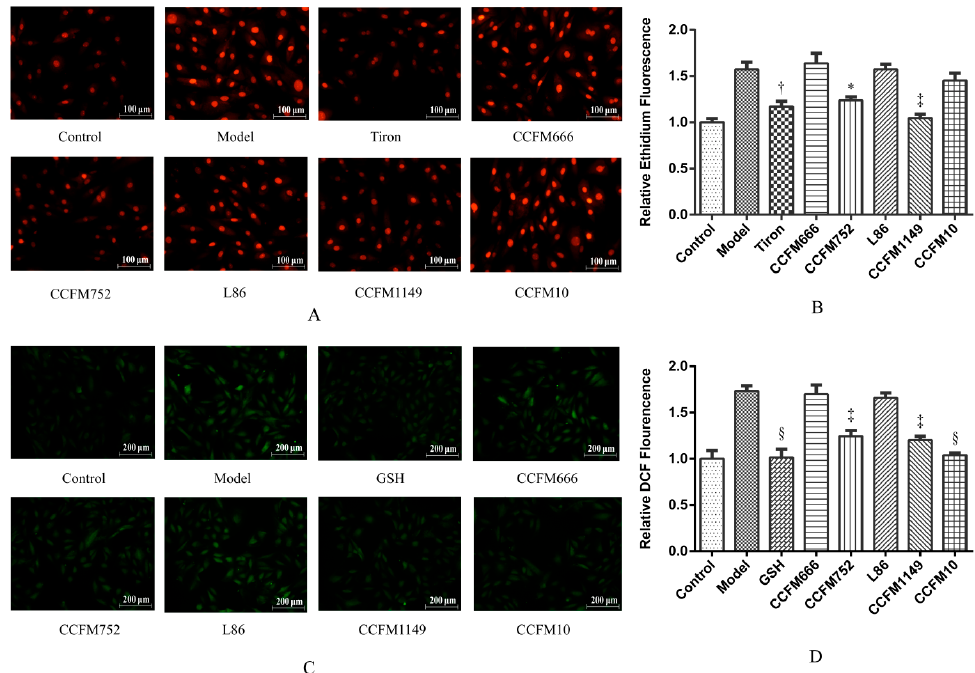
Figure 1. Relative intracellular reactive oxygen species (ROS) levels in different groups of A7R5 cells. ( A ) Photographs of ethidium fluorescence of A7R5 cells. ( B ) Relative intracellular O 2 · - levels of A7R5 cells. ( C ) Photographs of (dichlorofluorescein) (DCF) fluorescence of A7R5 cells. ( D ) Relative intracellular H 2 O 2 levels of A7R5 cells. Values are shown as means ± SEM (n = 3). * p < 0.05, † p < 0.01, ‡ p < 0.001, and § p < 0.0001, each probiotic supernatant intervention group compared with the model group.